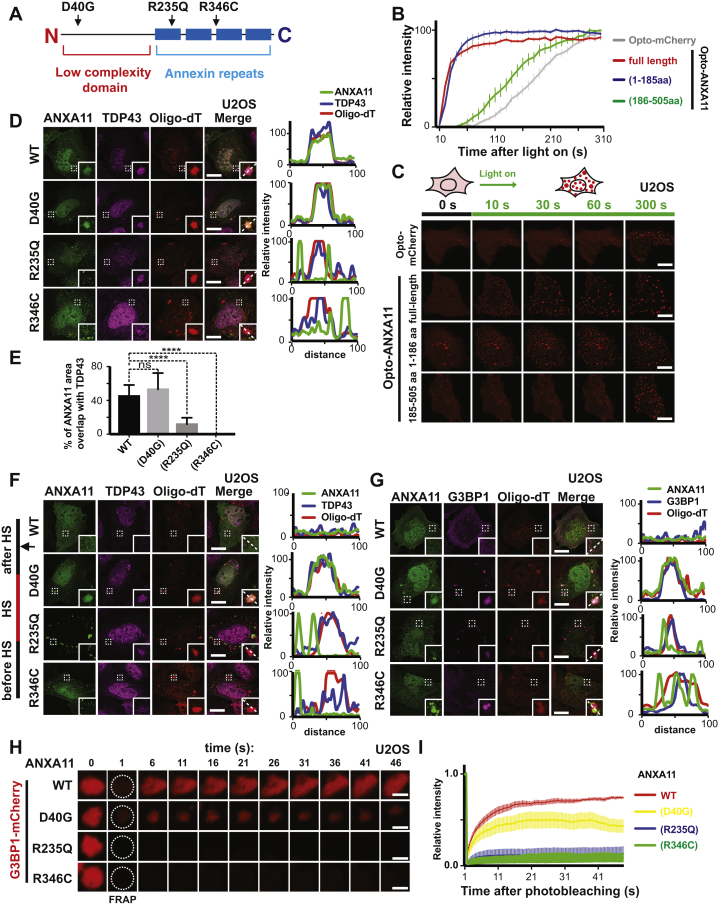
ALS-Associated Mutations in ANXA11 Disrupt RNA Granule Interactions, Related to Figure 4(A) A schematic map of ANXA11 protein with the position of ALS-associated mutants.(B) Quantification show the temporal evolution of the integrated fluorescence intensity from the expressed Opto-mCherry, ANXA11 full-length, NTD or CTD proteins during 300 seconds of light activation, n=11 (Opto-mCherry), 17 (ANXA11 full-length), 20(ANXA11 NTD), 20(ANXA11 CTD). Error bars = SEM.(C) U2OS were transfected with Opto-mCherry (CRY2olig-mcherry), Opto-ANXA11, Opto-ANXA11 NTD or Opto-ANXA11 CTD for 24hrs. Cells with similar Opto-ANXA11 expression levels were exposed to 0.2% 488nm light to initiate oligomerization. Scale bar: 30 μm.(D) Co-localization of ANXA11 or ANXA11 ALS-associated mutants with TDP43 and mRNA labeled by Oligo-dT. U2OS cells expressing mEmerald labeled ANXA11 or ANXA11 ALS-associated mutants were heat shocked for 30 mins, fixed, and then hybridized with Cy3-Oligo dT(30) and immunostained with antibodies against TDP43 to label RNA granules. The extent of co-localization of ANXA11 or the ALS-associated mutants with the RNA granules is plotted in the line-scans to the right.(E) Quantification of percentage of area of ANXA11 structures co-localizing with TDP43-labeled RNA granules in (D). One-way ANOVA, ns, not significant. ∗∗∗∗p < 0.0001. Error bars = SEM. N=12 (WT), 7 (D40G), 6 (R235Q), 7(R346C).(F) Co-localization of ANXA11 or ANXA11 ALS-associated mutants with RNA granules labeled by TDP43 and mRNA labeled by Oligo-dT after heat shock (HS). U2OS were heat shocked for 30 mins and then moved to 37oC for 4 hrs to allow recovery. The cells were then fixed, hybridized with Cy3-Oligo dT(30) followed by immunostaining with antibodies against TDP43 to label RNA granules. Linescan analysis show the related intensity profiles of ANXA11 or ALS-associated mutations with mRNA (Cy3 Oligo-dT) and TDP43. Scale bar: 30 μm.(G) Co-localization of ANXA11 or ALS-associated ANXA11 mutants with RNA granules labeled by G3BP1 and mRNA (right panel) after heat shock (HS). U2OS were heat shocked for 30 mins and then moved to 37oC for 4 hrs to allow recovery. The cells were then fixed, hybridized with Cy3-Oligo dT(30) followed by immunostaining with antibodies against G3BP1 (right panel) to label RNA granules. Linescan analysis show the related intensity profiles of ANXA11or ALS-associated ANXA11 mutants with mRNA (Cy3 Oligo-dT) and G3BP1. Scale bar: 30 μm.(H) U2OS cells expressing mCherry-G3BP1 to label RNA granules were co-transfected with ANXA11-mEmerald, ANXA11(D40G)-mEmerald, ANXA11(R235Q)-mEmerald or ANXA11(R346C)-mEmerald for 24 hrs. Cells were heat shocked (43oC) for 30 min, A single G3BP1-positive puncta in each of the different transfected cells was photobleached and recovery of fluorescence into the puncta was monitored by time-lapse imaging. Scale bar: 1 μm.(I) Quantification of H. N=7(WT), 9(D40G), 8(R235Q), 7(R346C). Error Bars=SEM.